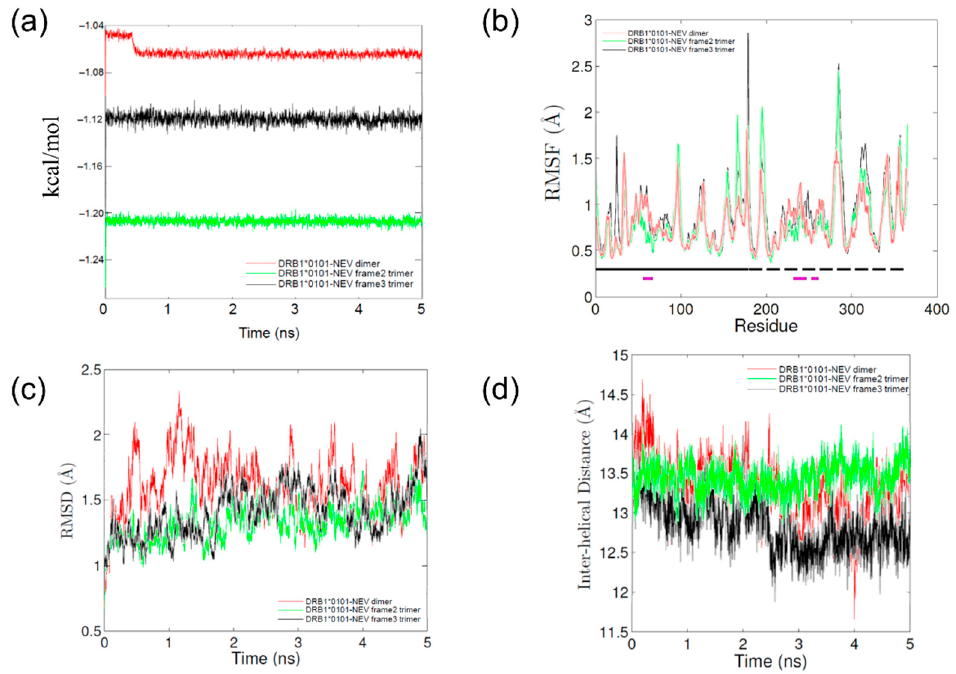
Figure 3. Parameter profiles of molecular dynamics (MD) simulations of nevirapine-bound HLA-DRB1*01:01. ( a ) Calculated energies vs. time plot; ( b ) RMSF values of polypeptide backbone. The location of α and β chains and residues that comprise the peptide binding groove helices are indicated by the solid and dashed lines running just above the x -axis, respectively. The α chain ( solid black ), α chain helix ( solid purple ), β chain ( dashed black ), and β chain helix ( dashed purple ); ( c ) Root mean square deviation (RMSD) values of polypeptide backbone vs. time plot; and ( d ) The average distance between each C α in the helix of the α chain and the closest C α atom in the helix of the β chain.